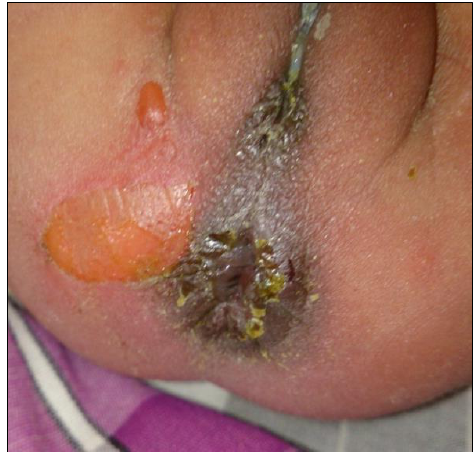
Figure 2: Resolution of edema and hematoma with progressing healing after a